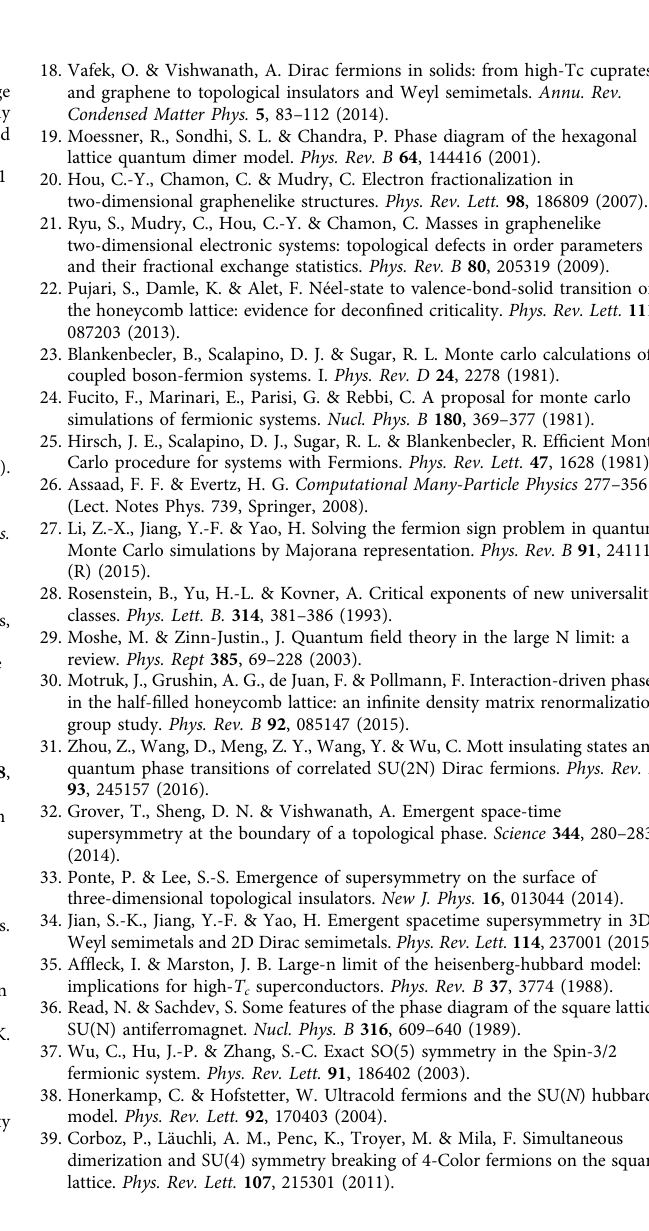
Fig. 4 The Binder ratio and data collapse analysis. a The Binder ratio with different J / t and different L up to L = 24 for N = 3 is obtained from sign-problem- free Majorana QMC; the Kekule-VBS phase transition occurs at J c / t ≈ 2.9. b Data collapsing according to the scaling relation is used to determine ν . From the fi tting, ν = 1.07 for N